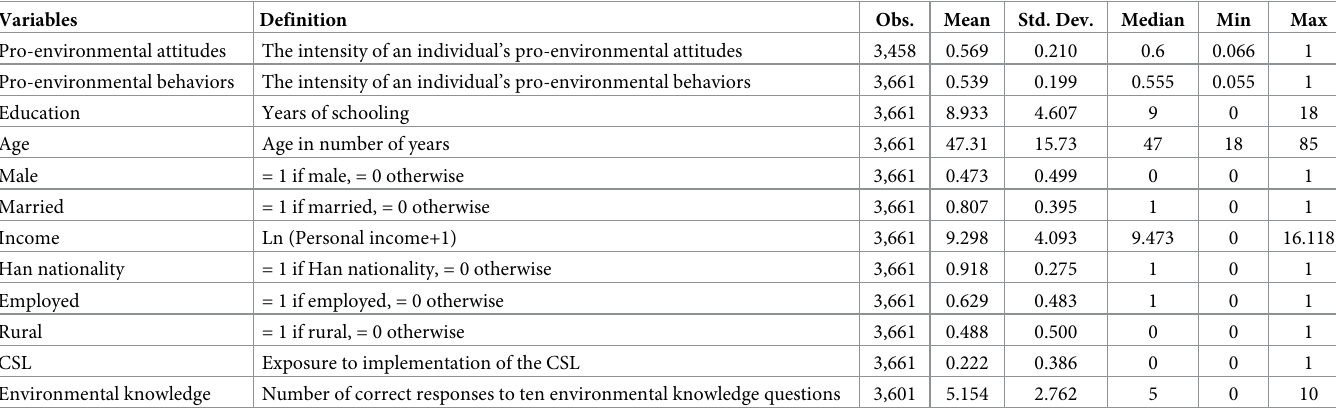
Table 2. Descriptive